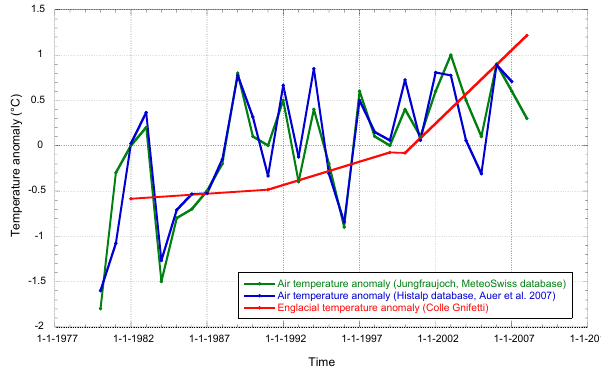
Fig. 12. Measured air temperature anomaly with data from Jungfraujoch (MeteoSwiss, anomaly reference period 1980 to 2008) and from the Histalp database (Auer et al., 2007, anomaly reference period 1980 to 2007) in comparision with the englacial temperature anomaly measured in 20m depth at Colle Gnifetti (anomaly refer- ence period for the anomaly 1982 to 2008, the used temperature measurements were CG82-1/82, CG91-A/91, CG99-2/99, CG00- 1/00,